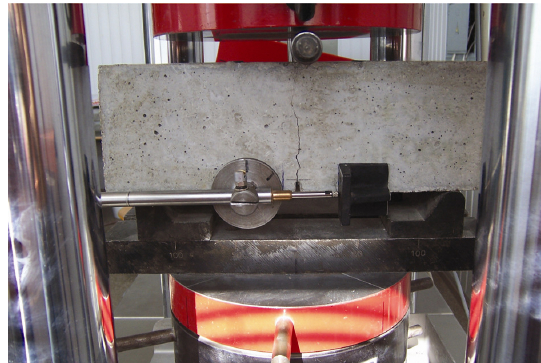
Fig. 1. Testing of concrete bending